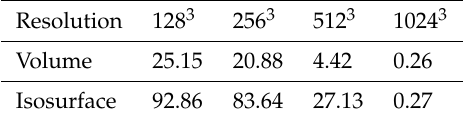
Table 2. Frames-per-second on different data resolutions (column) and 3D renderers